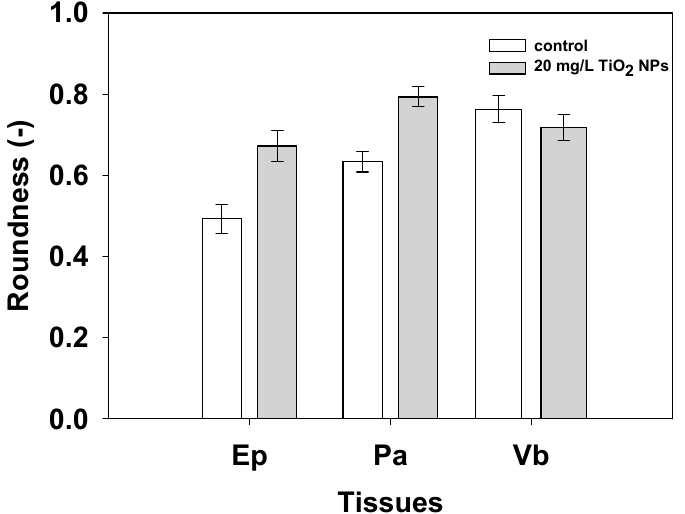
Figure 8. Cellular roundness by tissue type for the tomato root control, and the root exposed at 20 mg/L of TiO 2 NPs for Ep, Pa, and Vb. Bars indicate standard errors.